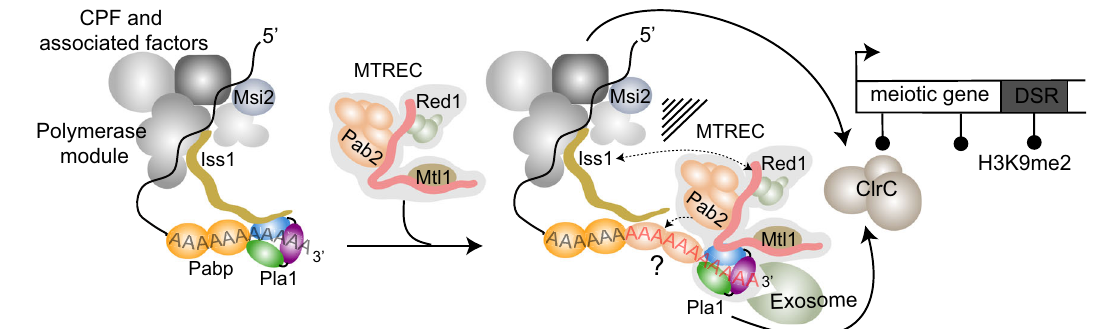
Fig. 8 | Model of the role of Pla1 in MTREC-mediated degradation of CUTs. MTRECcomplexisrecruitedtoCUTsandmeioticmRNAsduringtheirtranscription byanotwellunderstoodmechanism.Pla1,aspartoftheCPF,isresponsibleforthe initialpoly-adenylationofCUTsand the resulting poly(A)tail is likelybound bythe canonicalpoly(A)bindingproteinPabp.MTRECcomplexsequestersPla1fromCPF via Red1, replacing Iss1 that anchors Pla1 to CPF. MTREC-bound Pla1 hyper- adenylatesCUTs.Wesuggestthatthenon-canonicalpoly(A)-bindingprotein,Pab2,